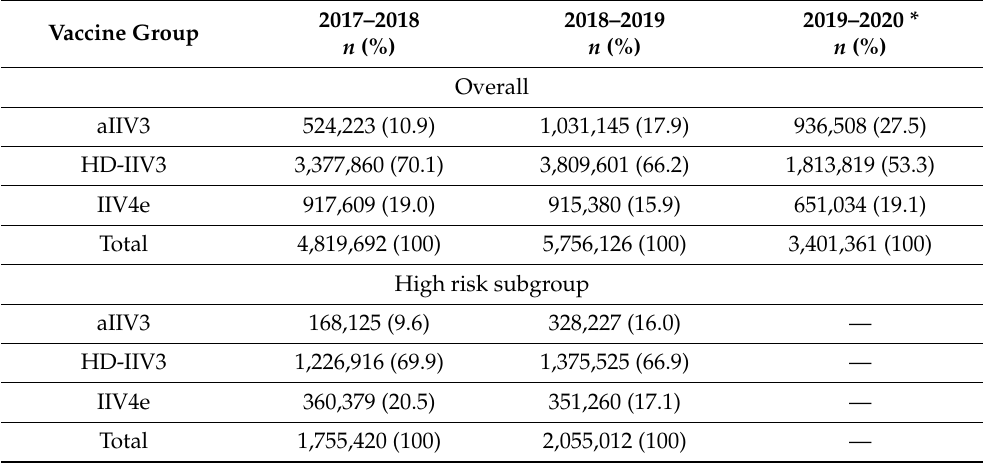
Table 1. Numbers of vaccinated subjects ≥ 65 years of age used in the analysis for each season. Vaccine Group